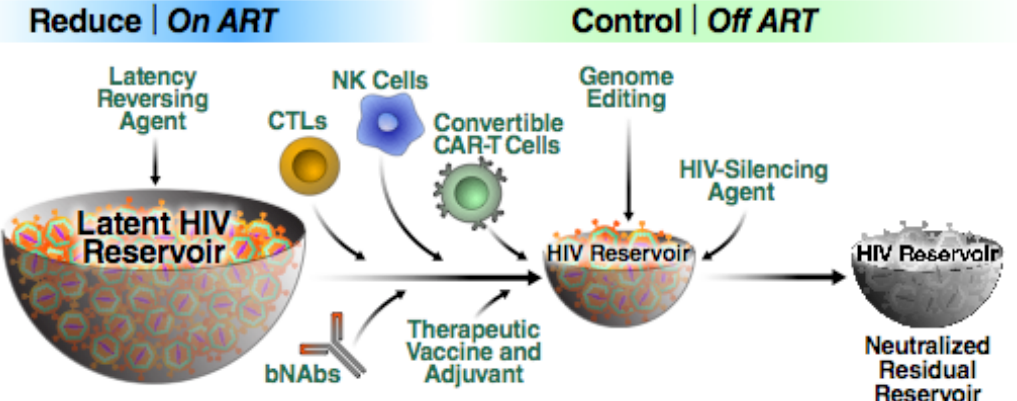
Figure 5. Schematic representation of the “reduce and control” approach. First, a combination of e ff ective, non-toxic LRAs are employed in order to render reservoir cells visible to the immune system. The reservoir is then reduced in size likely through the use of multiple agents including bNAbs, various killer cells and therapeutic vaccines. The residual virus can be controlled by the same agents used to reduce the size of the reservoir. However, this shrunken reservoir could form an attractive target for additional transcriptional silencing approaches. We believe it likely that some form of this combinatorial “reduce and control” strategy will emerge as a means of achieving a sustained HIV remission in the absence of ART.